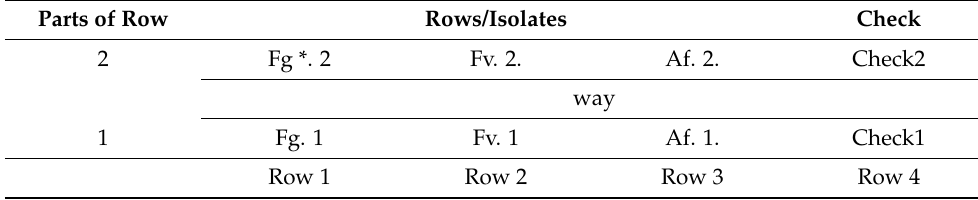
Table 1. Structure of a four-row plot. * Fg = F. graminearum , Fv = F. verticillioides , Af = A. flavus . Parts of Row Rows/Isolates Check 2 Fg *. 2 Fv. 2. Af. 2. Check2 way 1 Fg. 1 Fv. 1 Af. 1. Check1 Row 1 Row 2 Row 3 Row